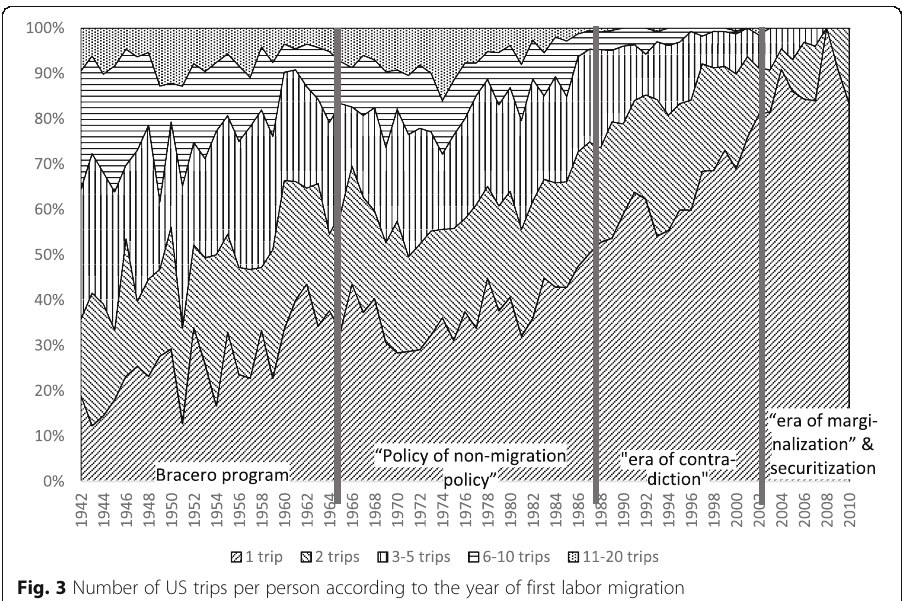
Fig. 3 Number of US trips per person according to the year of first labor